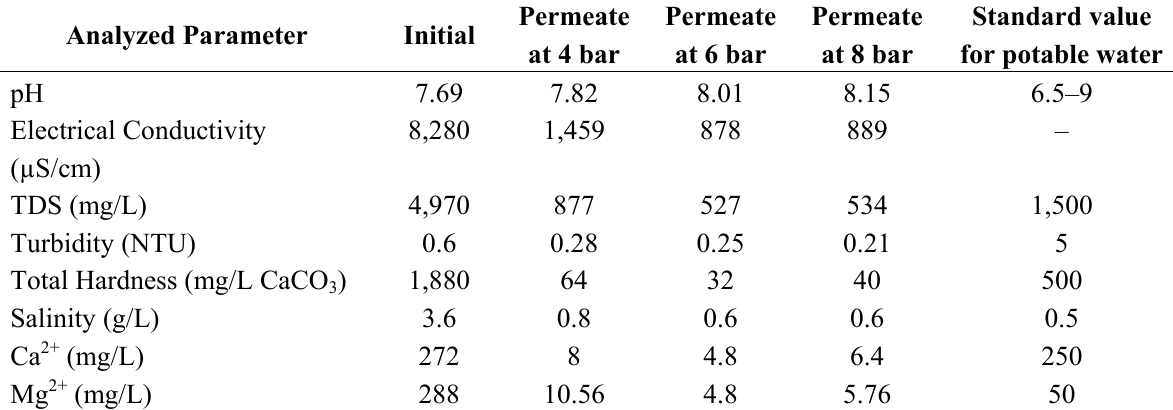
Table 3. Analysis of the feed and permeates at various pressures (Sample